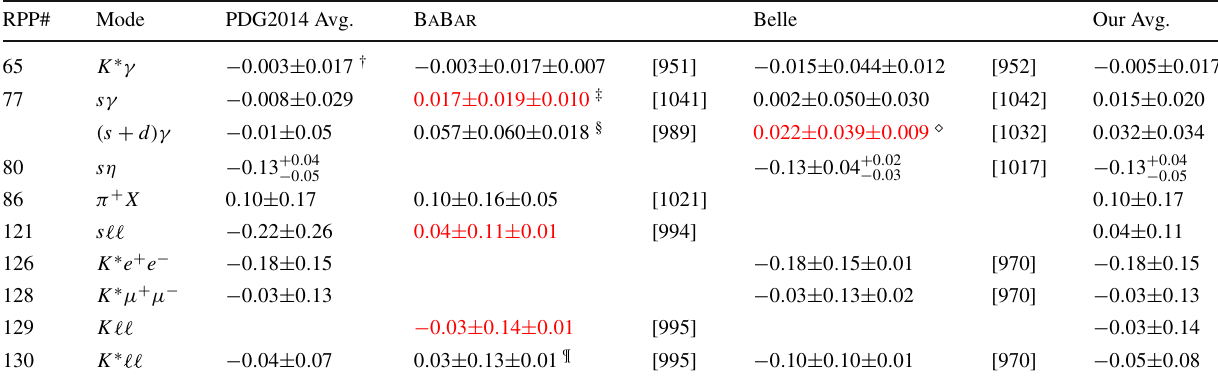
Table 245 CP asymmetries of charmless hadronic decays of B ± / B 0 admixture. Where values are shown in red (blue), this indicates that they are new published (preliminary) results since PDG2014